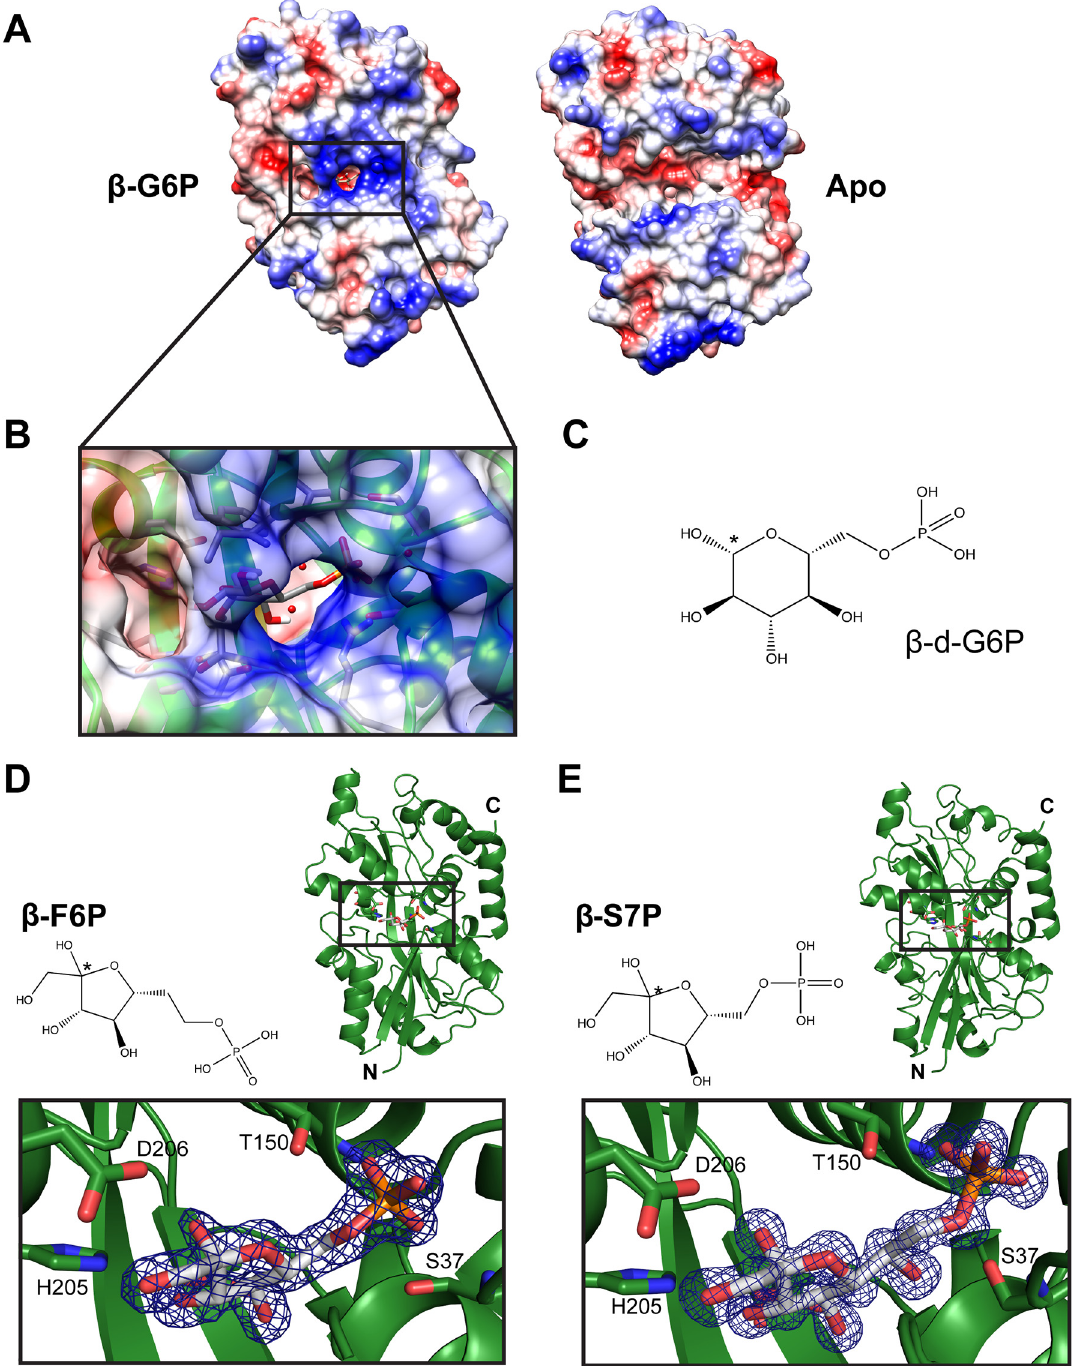
Fig 2. Electrostatic surface mapping of AfuA and additional ligand-bound structures. (A) Electrostatic surface potential of apo (right) and G6P-bound (left) AfuA. Potential values range from -10 (red) to +10 kJ/mol (cid:1) e (blue). (B) Magnified view of G6P-AfuA binding cleft with electrostatic surface map overlay. Residues proximal to the G6P molecule are shown as sticks. Water molecules are shown as red spheres. (C) Chemical structure of β -G6P. * denotes the anomeric carbon. (D, E) Ribbon diagrams showing A . pleuropneumoniae AfuA in complex with (D) F6P or (E) S7P. Inset boxes below each ribbon structure show the 2F 0 -F c map contoured at 2 σ around each